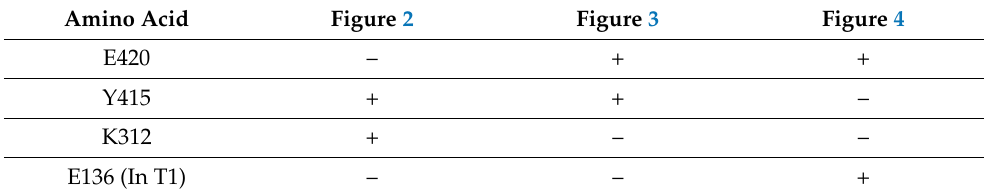
Table 1. Protonation States of Those Residues that can Exchange Protons. Amino Acid E420 – + + Y415 + + – K312 + – – E136 (In T1) – – +